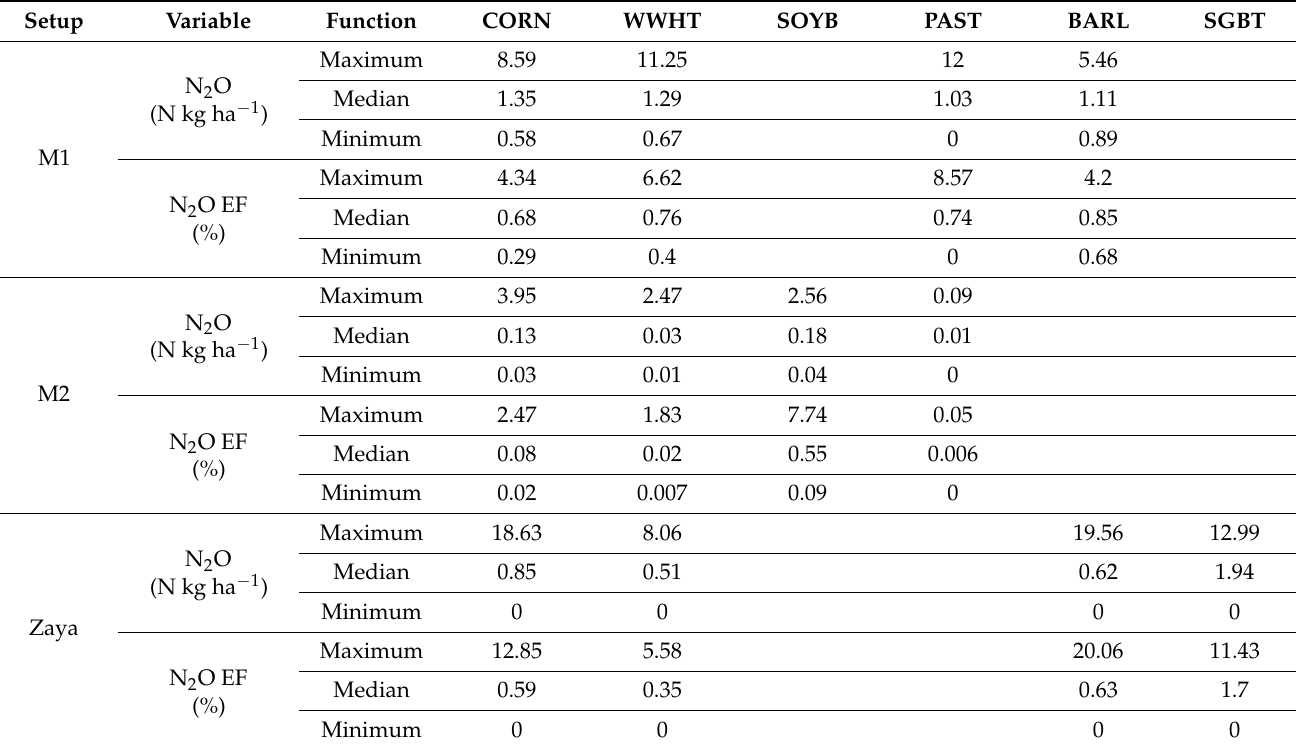
Table 6. Simulated annual N 2 O emissions (N kg ha − 1 ) and calculated EFs for N 2 O (%) for the crops in the Melk and Zaya catchments for the years